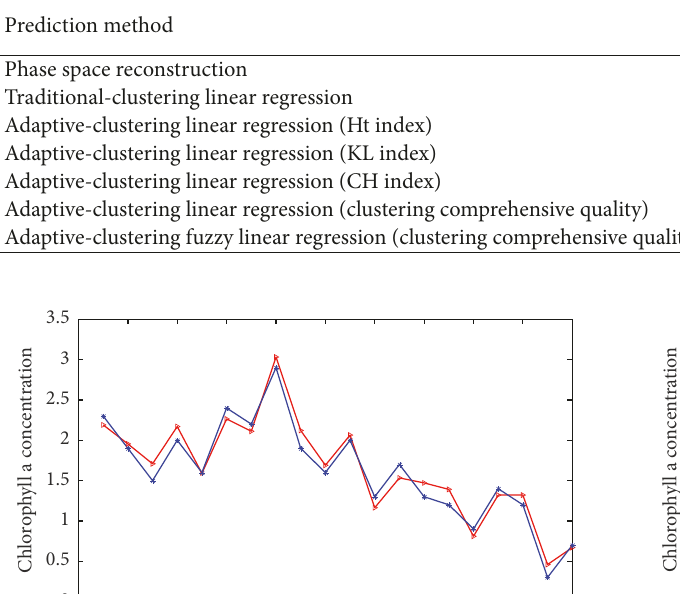
Table 3: Comparison of results.